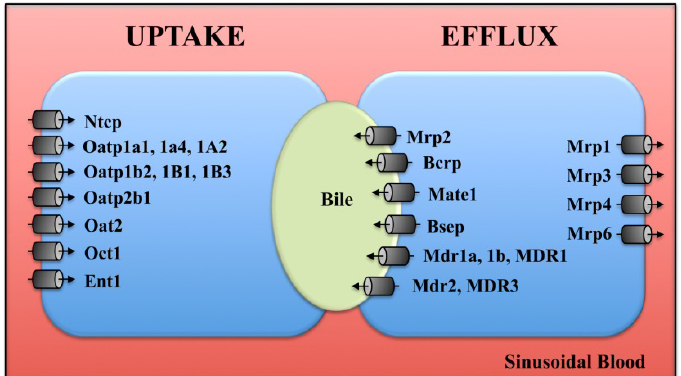
Figure 1. Subcellular localization of transporters in hepatocytes. The localization and orientation of uptake and efflux transporters (primarily rodent isoforms) at the sinusoidal and canalicular plasma membranes are